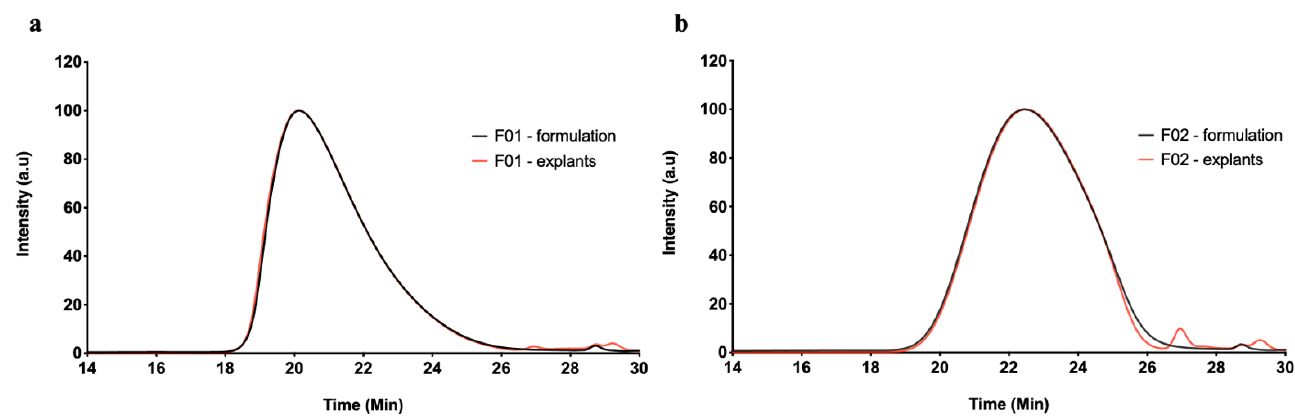
Figure 9. GPC–RI chromatograms of F01 ( a ) and F02 ( b ) (m)PEG–PTMC based formulations (black) and depots explanted 28 days post administration to rats (red). Table 4. GPC–RI values obtained from F01 and F02 formulations pre- and post-in vivo administration. Formulation